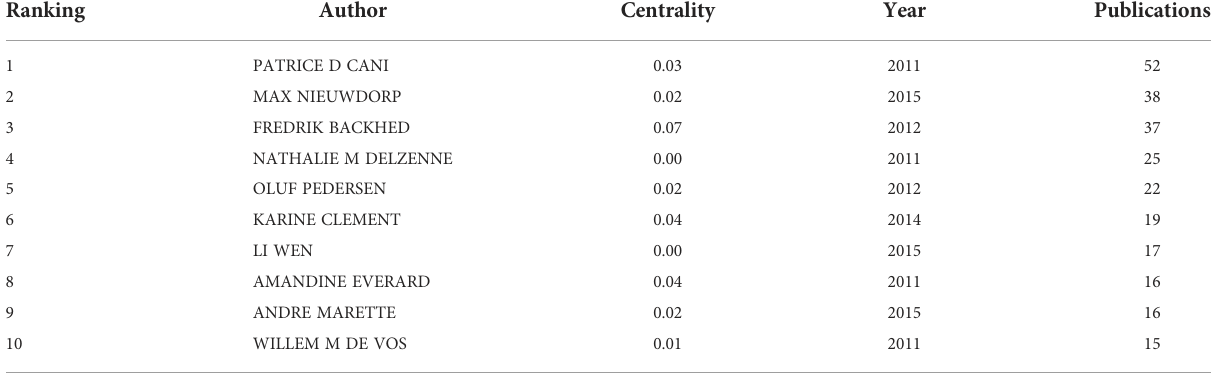
TABLE 3 Top 10 authors with the highest number of